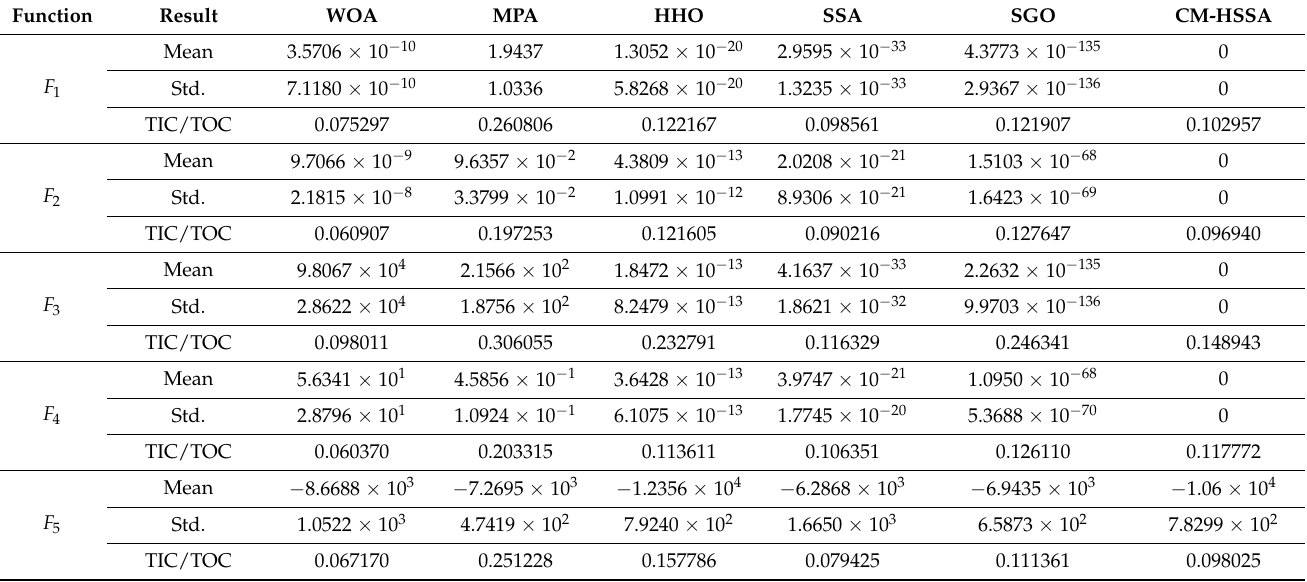
Table 2. Experimental results of six